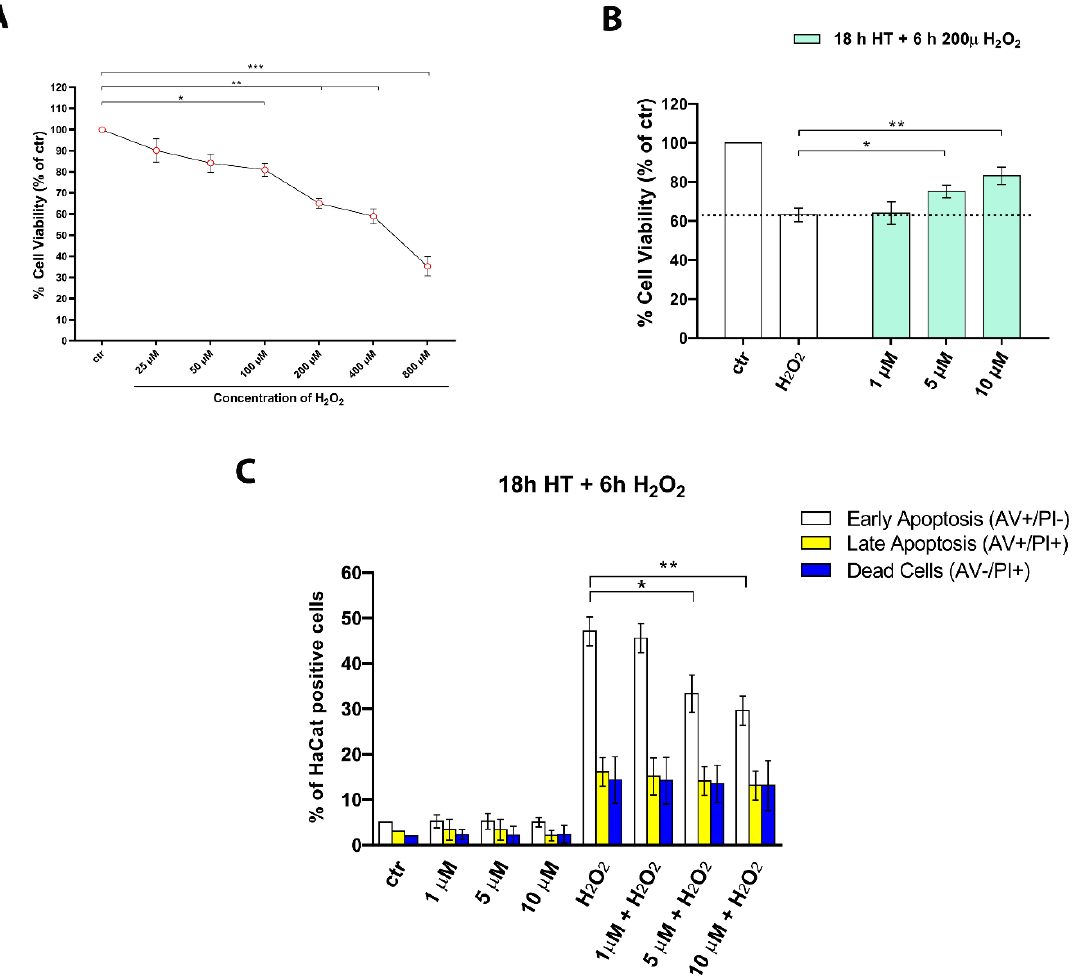
Figure 5. HT ameliorated cytotoxicity and apoptosis induced by H 2 O 2 in keratinocytes. ( A ) HaCaT cells were cultured for 6 h in the presence of H 2 O 2 (25–800 µ M) before the MTT assay. The results are expressed as means ± SD of three independent experiments and reported as percentage vs. the untreated control (2-way ANOVA, * p < 0.05, ** p < 0.01, and *** p < 0.001). ( B ) HaCaT cells were cultured for 18 h in the presence of HT (1–10 µ M) before treatment with H 2 O 2 for 6 h. The results are expressed as means ± SD of three independent experiments reported as percentage vs. the untreated control (2-way ANOVA, * p < 0.05 and ** p < 0.01 vs. control). ( C ) Flow cytometric analysis of annexin V and propidium iodide (PI) double staining in HT-pretreated HaCaT cells for 18 h after H 2 O 2 exposure for 6 h. Bars indicate the total percentage of early (annexin V-positive cells/PI-negative cells) and late apoptotic events (annexin V/PI-double positive cells) as well as necrotic cells (annexin V-negative cells/PI-positive cells). The results are representative of three independent experiments and expressed as mean ± SD (ANOVA, * p < 0.05 and ** p <